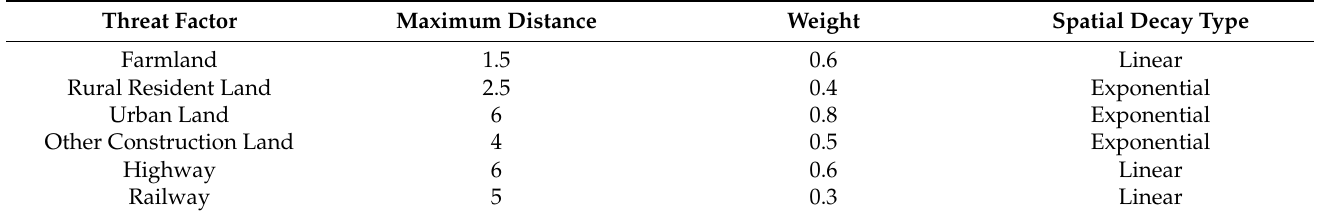
Table 1. Attributes of threat data.